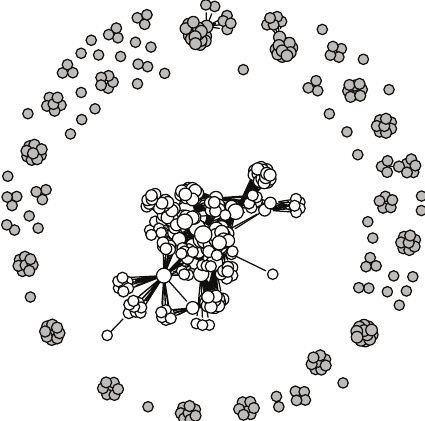
Figure 5: The DSM IV graph constructed by connecting all symptoms that belong to the same disorder. The 208 white nodes belong the giant component and the remaining 231 gray nodes consist of 28